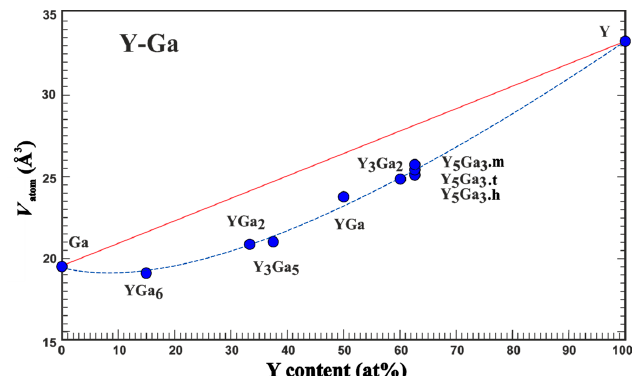
Figure 1. Average atomic volume V atom vs yttrium concentration in the compounds of yttrium with gallium. The red line presents the behavior expected from the Vegard rule. The blue line only serves as an eye guide.